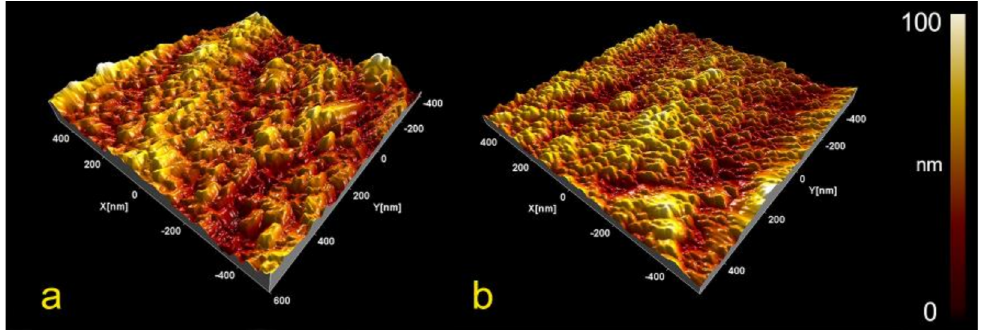
Figure 2. Three-dimensional reconstructions of the atomic force microscopy (AFM) data for the Ti ( a ) and APTES-coated ( b ) titanium surfaces. Similar nanostructure patterns were observed for both sets of